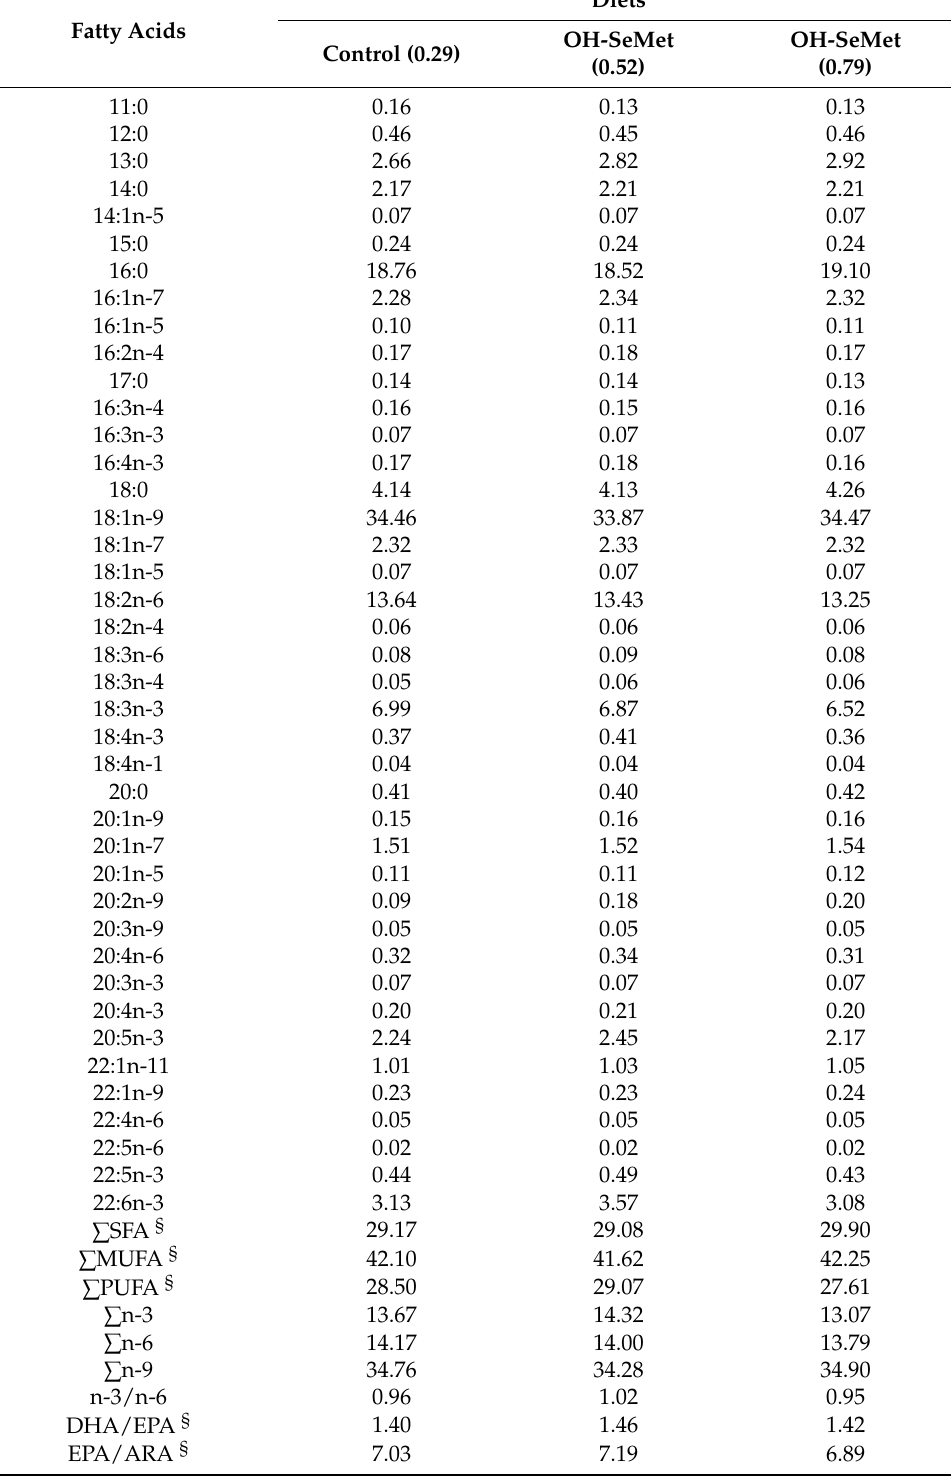
Table 2. Fatty acid composition of the experimental diets containing different Se levels (% total identified fatty